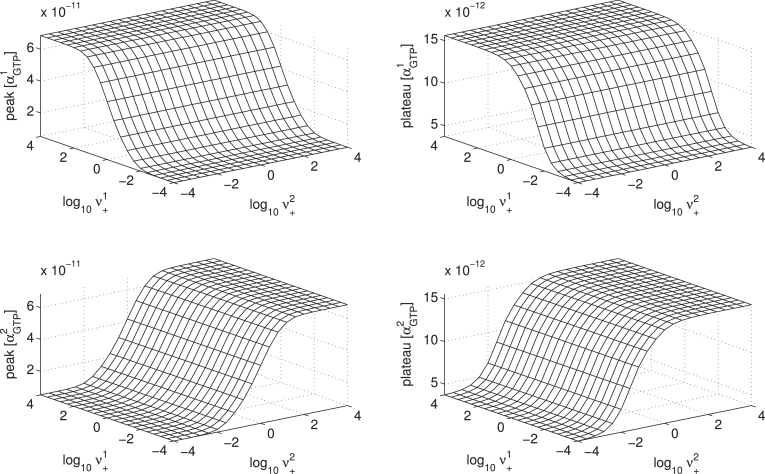
Response surfaces for varying ν+1,2, with expected monotonic relationships. Here, [L]=10−5 M.